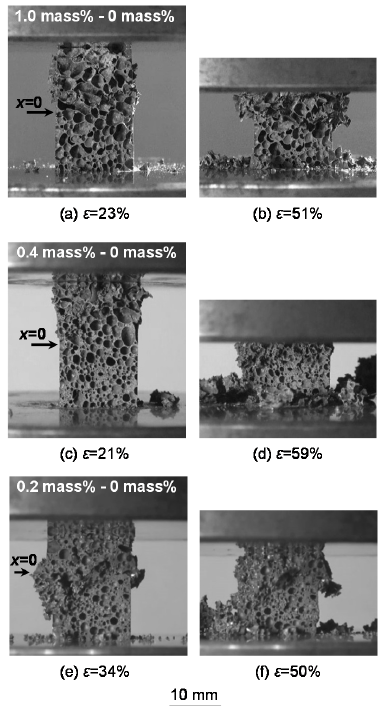
Figure 4. Typical fracture states: ( a ) 1.0–0 mass % TiH 2 ; ε = 23%; ( b ) 1.0–0 mass % TiH 2 ; ε = 51%;